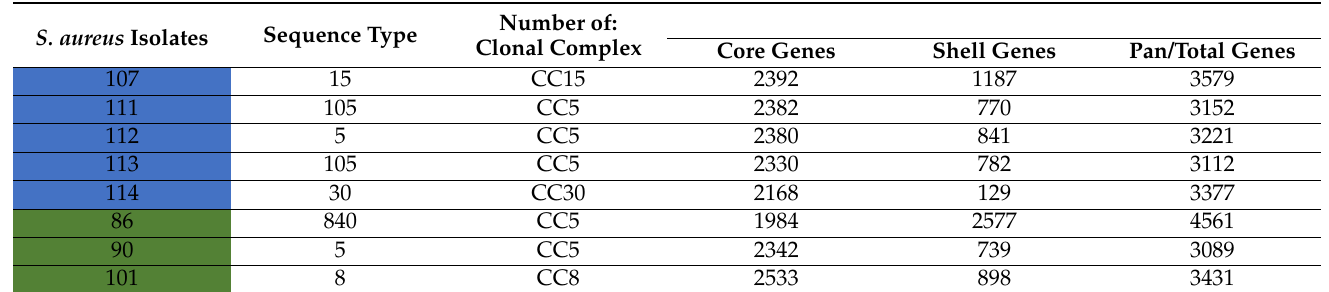
Table 3. Sequence types and clonal complexes of S. aureus